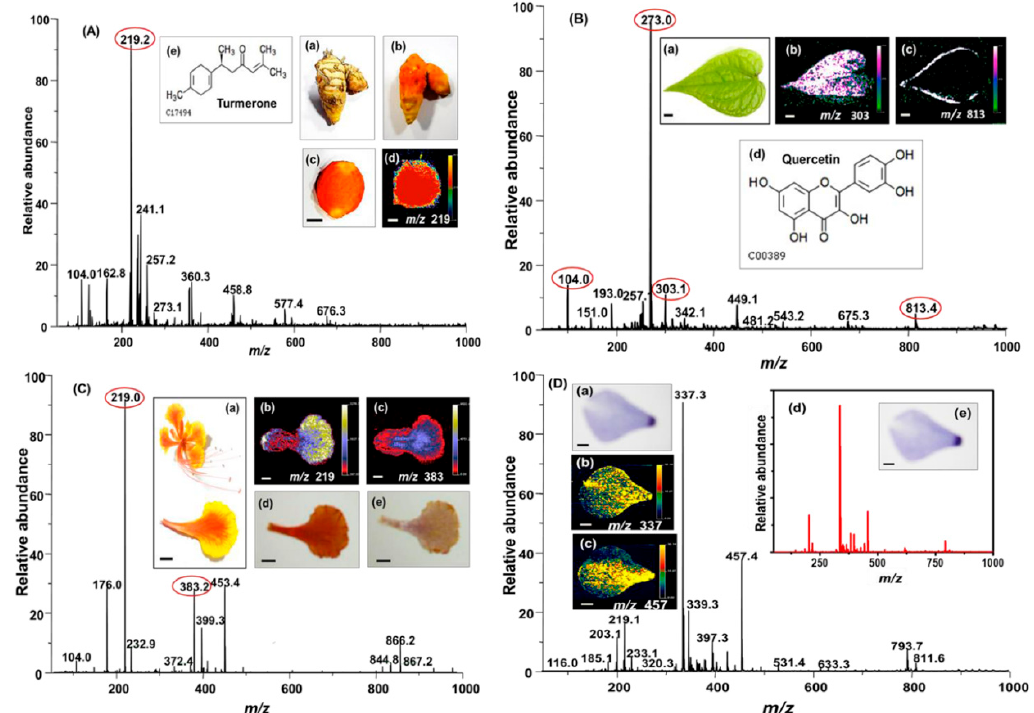
Figure 9. ( a ) Desorption electrospray ionization mass spectrometry (DESI–MS) spectrum from a turmeric rhizome slice of an imprinted nylon nanofiber mat. ( a , b ) Optical images of a whole and unskinned turmeric rhizome. ( c ) Imprinted slice on a nylon nanofiber mat. ( d ) DESI–MS image at m / z 219 due to α -turmerone shown. Reproduced from [91], with permission from ACS Publications, 2019.